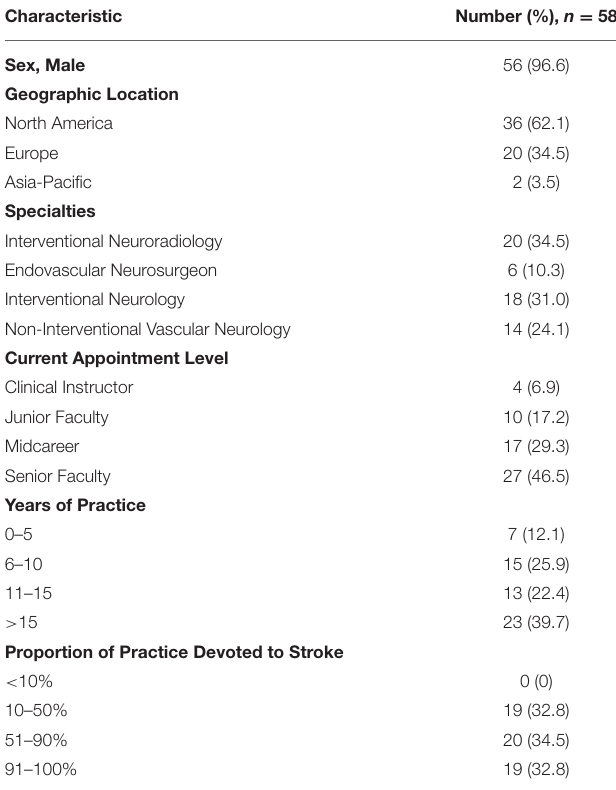
TABLE 1 | Characteristics of physician survey